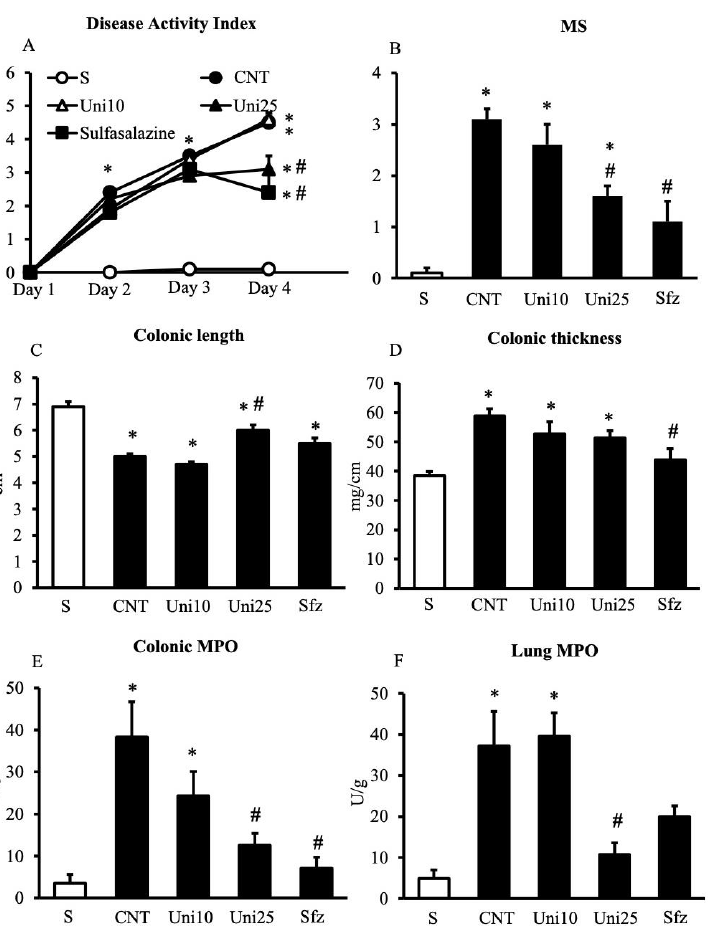
Figure 1. Effects of UniPR1331 on TNBS-induced inflammatory responses. Disease Activity Index ( A ), macroscopic score (MS) ( B ), colonic length ( C ), colonic thickness ( D ), colonic myeloperoxidase (MPO) ( E ) and lung MPO ( F ) activity assessed in vehicle-treated normal mice (S) and in TNBS-treated mice administered with vehicle (CNT), UniPR1331 10 mg/kg (Uni10), UniPR1331 25 mg/kg (Uni25), and sulfasalazine 50 mg/kg (Sfz) ( n = 5–15 independent values per group). * p < 0.05 vs. S mice; # p < 0.05 vs. CNT mice; one-way or two-way (DAI) ANOVA followed by Bonferroni’s post-test; Kruskal-Wallis followed by Dunn’s post-test (MS).